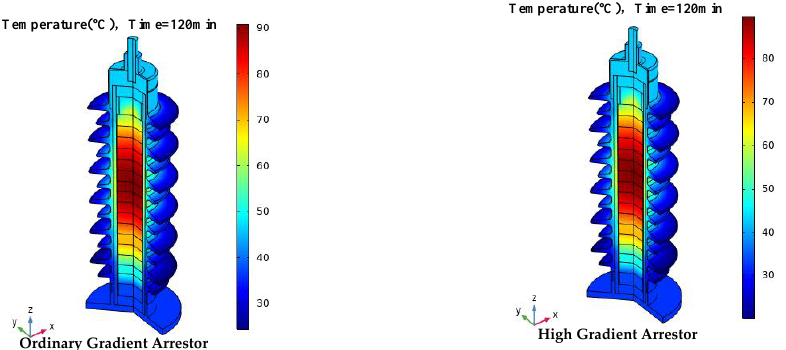
Figure 14. Temperature distribution of different valve arrestors at 3050 Hz for 120 min.